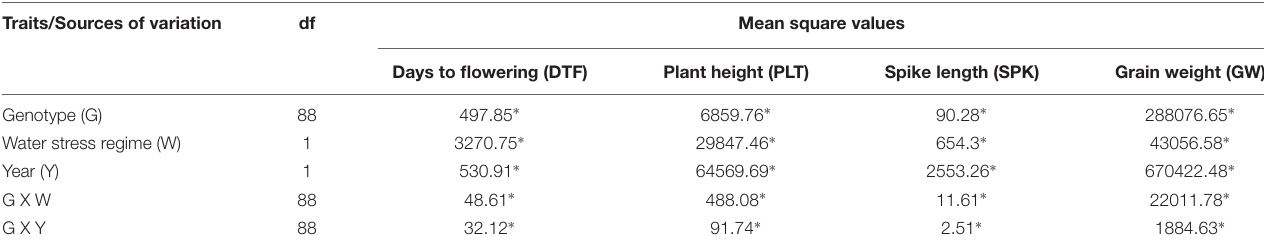
TABLE 4 | Genotypic variation in wheat germplasm set for field based traits recorded under well watered and water stress conditions. Traits/Sources of variation